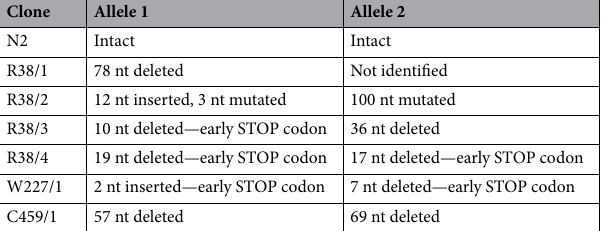
Table 1. Detailed description of nucleotide sequence modifications identified in individual PPOX alleles edited by CRISPR/Cas9. nt